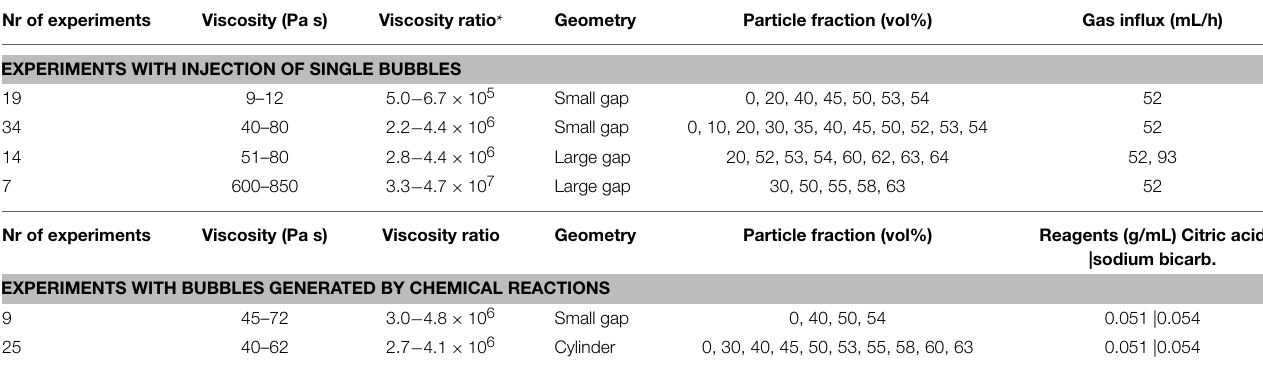
TABLE 1 | Experimental conditions explored in this